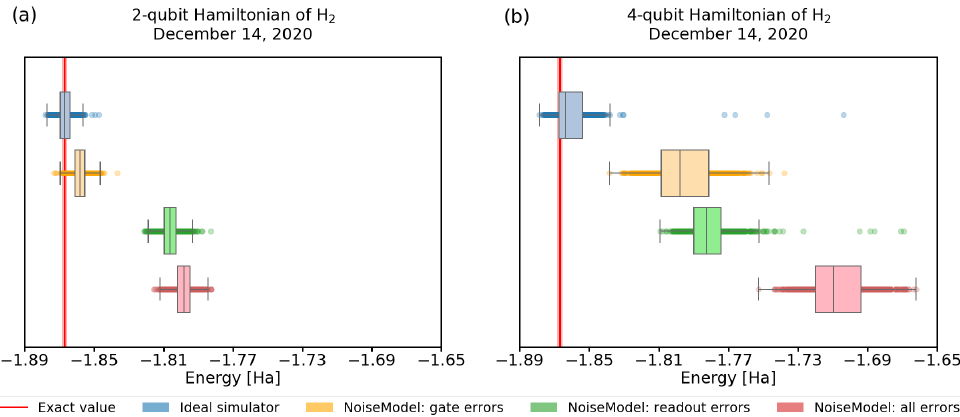
Figure 7. The calculations of H 2 energy were performed using simulator of real quantum hardware using a 2 and a 4 qubit Hamiltonian. We used quantum processor ibmq_santiago with noise model from December 14 2020. The number of shots was set to 4096. We minimized energy with the SPSA optimizer: ( a ) in case of 2-qubit Hamiltonian we used unrestricted maximum number of iterations and the R y variational form with depth 1, ( b ) in case of 4-qubit Hamiltonian the maximum number of iterations was set to 400 and we used the R y form with depth 2. The red line represents the physical ground-state energy ( − 1.86712 Hartree) and the light-red background represents the chemical accuracy ( ± 0.0015